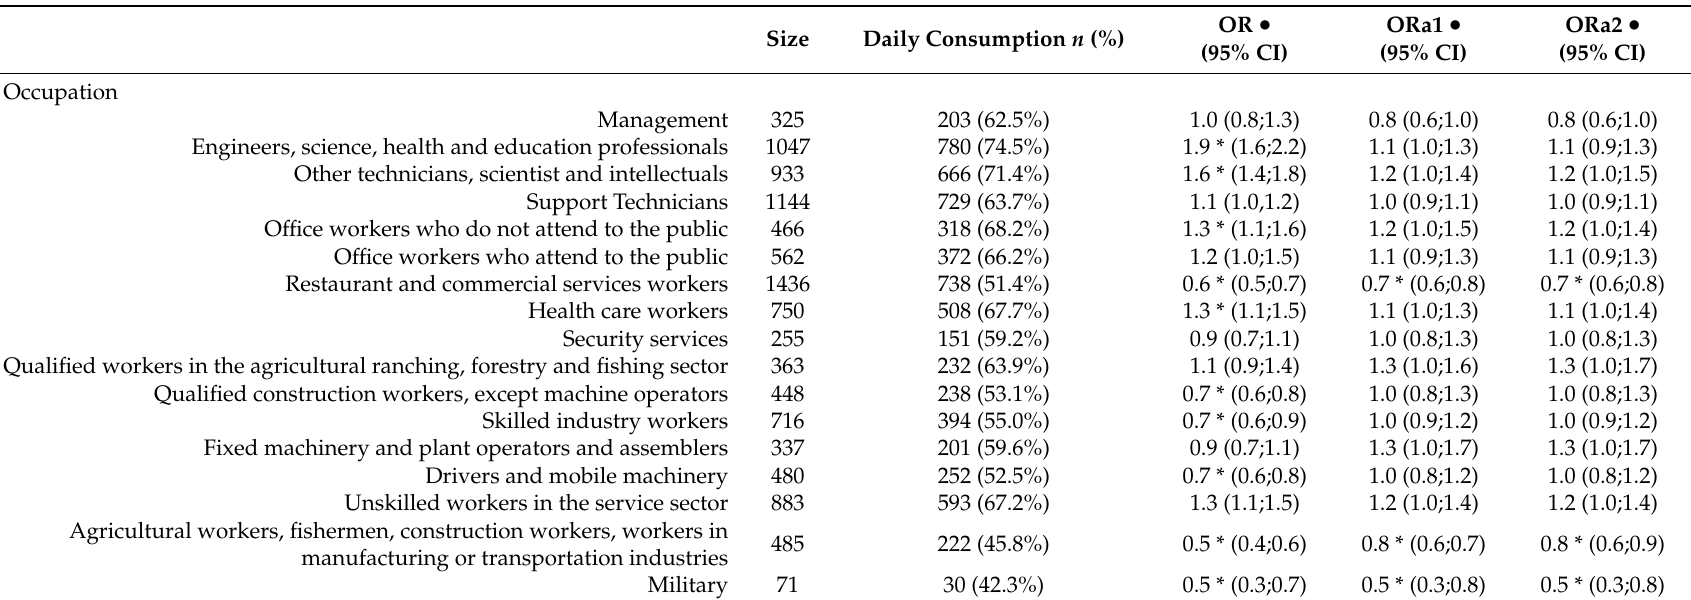
Table 3. Daily consumption of fruit by